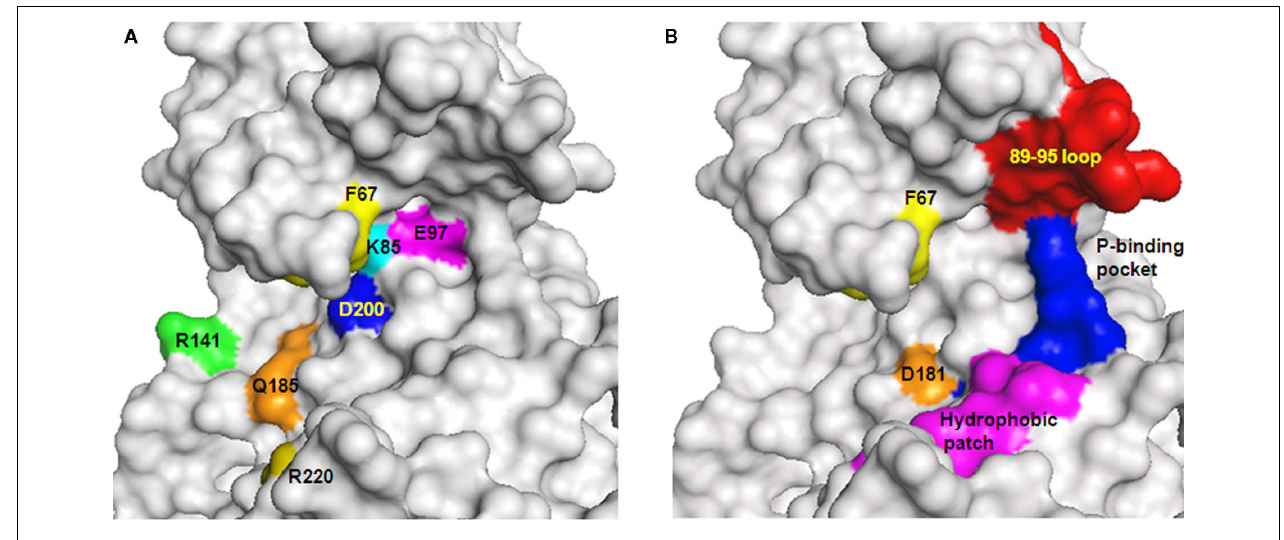
substrates: F67 (yellow), 89–95 loop (red), phosphate binding pocket (P-binding pocket, blue). D181 (orange) interacts with the pseudosubstrate. Sites interacting with L803-mts: F93 (within the 89–95 loop), hydrophobic patch (V214, I217Y216 magenta), and the phosphate binding pocket (blue). GSK-3 structure is based on PDB code 1gng and images were processed by PyMol